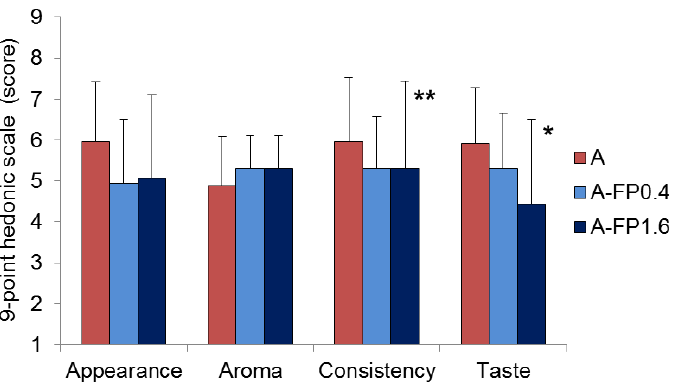
Figure 7. Sensory scores of A, A-FP0.4, and A-FP1.6 gels. Data are presented as the mean rating (n = 16). * and ** p < 0.05 and 0.01 vs. A gel.